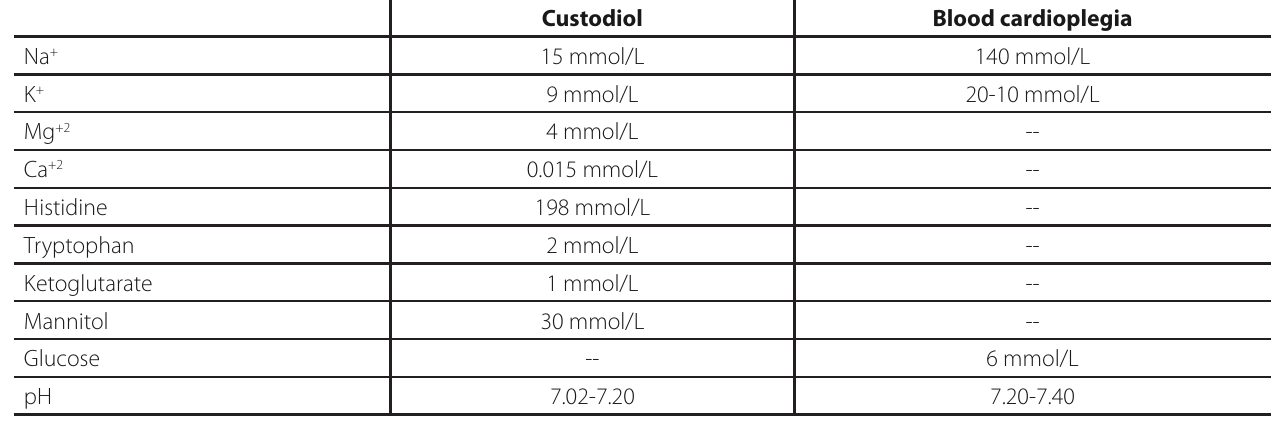
Table 2. Patients were divided into two groups Table 1. Composition of Custodiol versus blood cardioplegia.